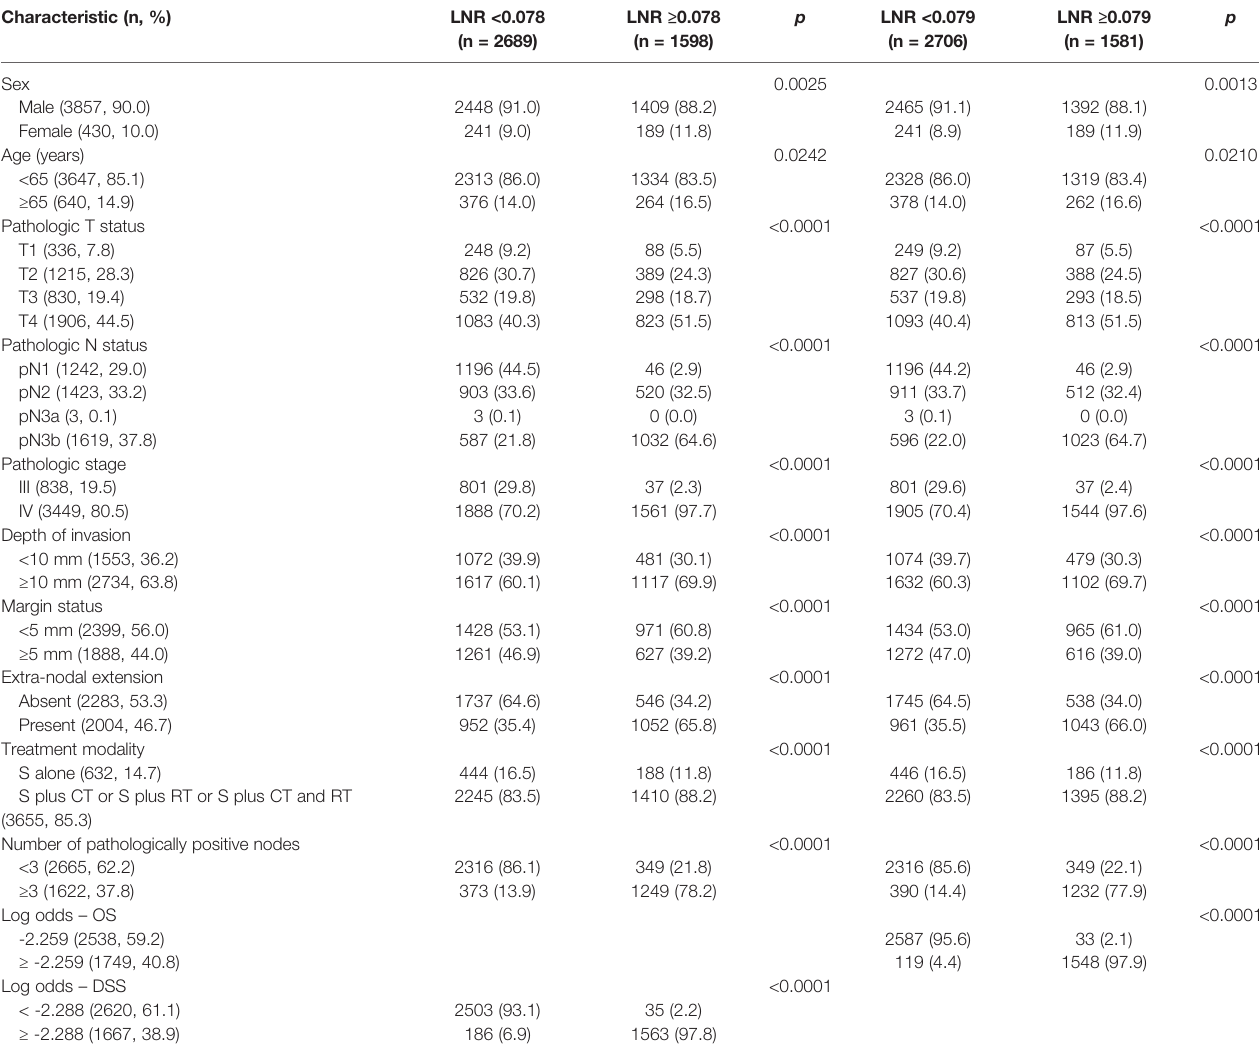
TABLE 1 | General characteristics of patients with oral cavity squamous cell carcinoma strati fi ed according to the lymph node ratio (cut-off value for 5-year disease- speci fi c survival: 0.078; cut-off value for 5-year overall survival: 0.079). Characteristic (n,